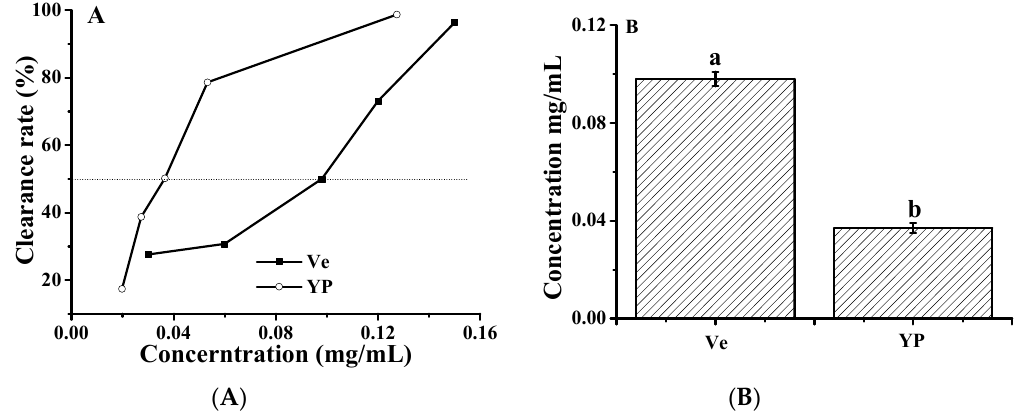
Figure 8. Hydroxyl radical scavenging activity of YP: ( A ) clearance rate as a function of YP or vitamin E (Ve) concentration and ( B ) IC 50 values of YP and Ve.